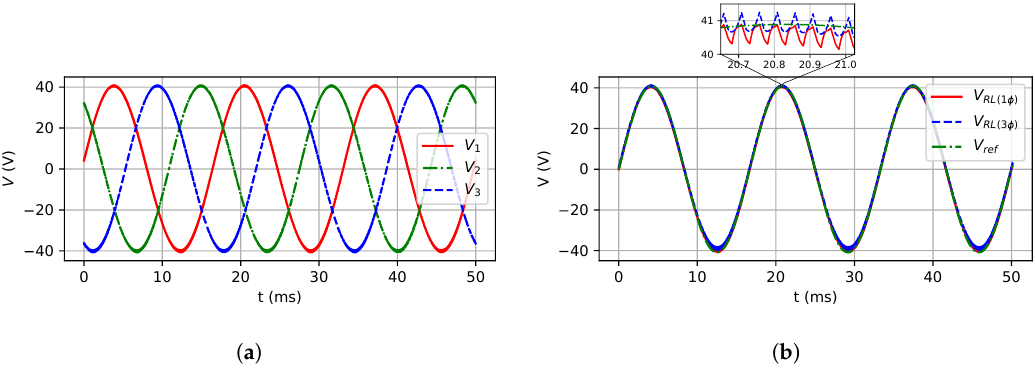
Figure 16. Load phase voltages for RL load case: ( a ) Three-phase model; ( b ) Single-phase and three-phase (leg 1) models.